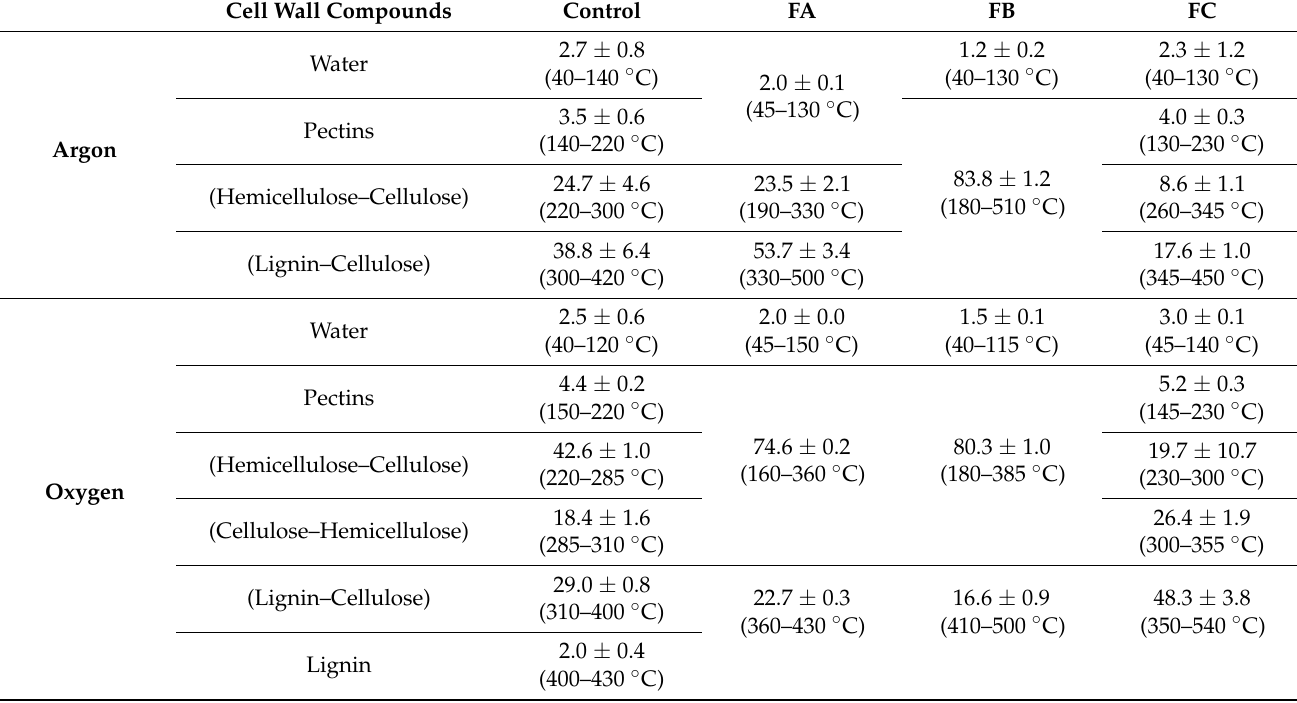
Table 5. Cell wall composition estimation (g/100g dry mass) under argon and oxygen with TGA 1 . Number of repetitions =